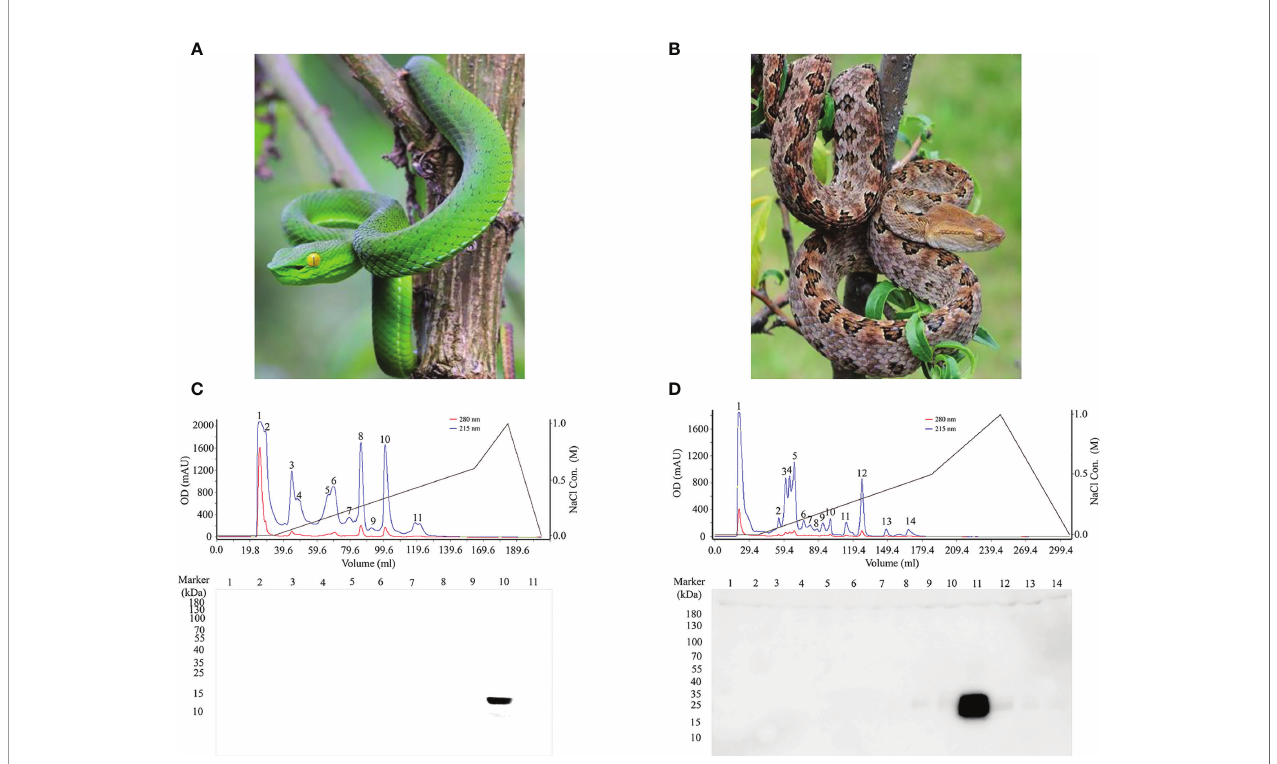
FIGURE 4 | Puri fi cation of natural antigens of PLA 2 and SVMP from T. stejnegeri and P. mucrosquamatus , respectively. Using FPLC, PLA 2 and SVMP were puri fi ed from crude T. stejnegeri (A) and P. mucrosquamatus venom (B) , respectively (photographs were provided by Ma Xiaofeng). Crude venom (50 mg) of T. stejnegeri and P. mucrosquamatus was dissolved in 1 ml of phosphate buffer, loaded into the FPLC system, and eluted with a sodium chloride gradient. 11 [ (C) , upper] and 14 fractions [ (D) , upper] were obtained from crude T. stejnegeri and P. mucrosquamatus venom, respectively. SDS-PAGE and Western blotting with anti-PLA2-pep-3 and anti-SVMP-pep-1 pAbs-p were used to detect the fractions. Results showed that the 10th fraction was the target PLA 2 protein in T. stejnegeri venom [ (C) , lower] and the 11th fraction was the target SVMP protein in P. mucrosquamatus [ (D) ,